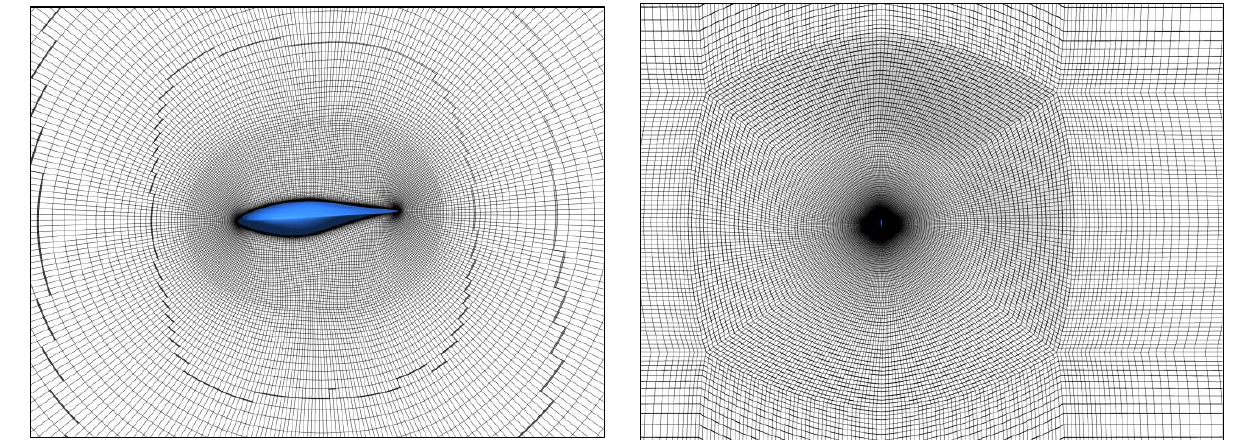
Figure 5. Blade surface mesh.